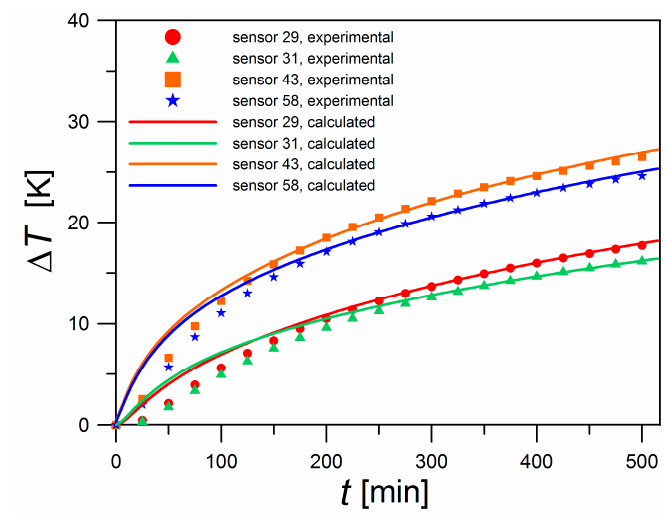
Figure 12. Comparison of experimental and computational results.